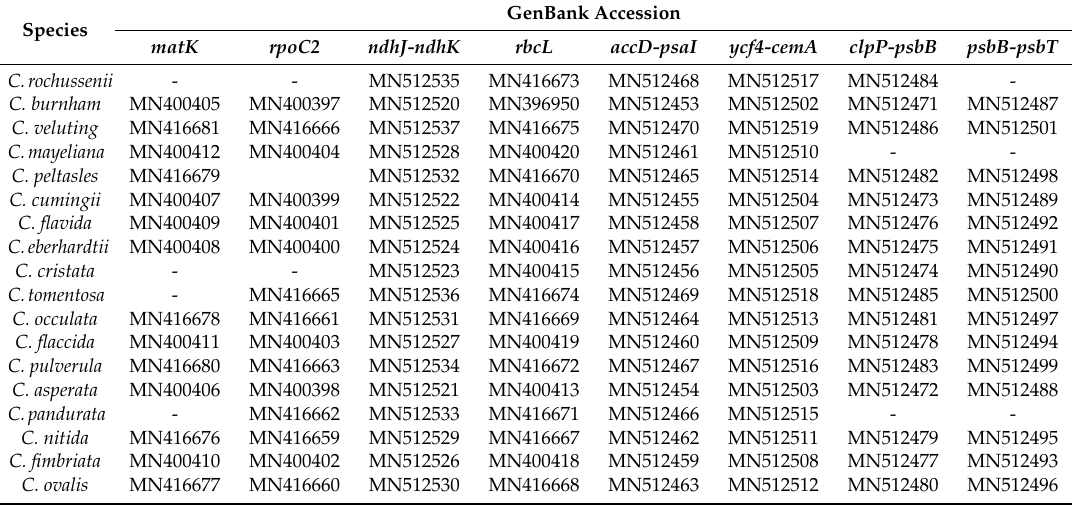
Table A1. GenBank Accession of Eight Chloroplast Fragments for 18 Coelogyne Species in the Study. Species